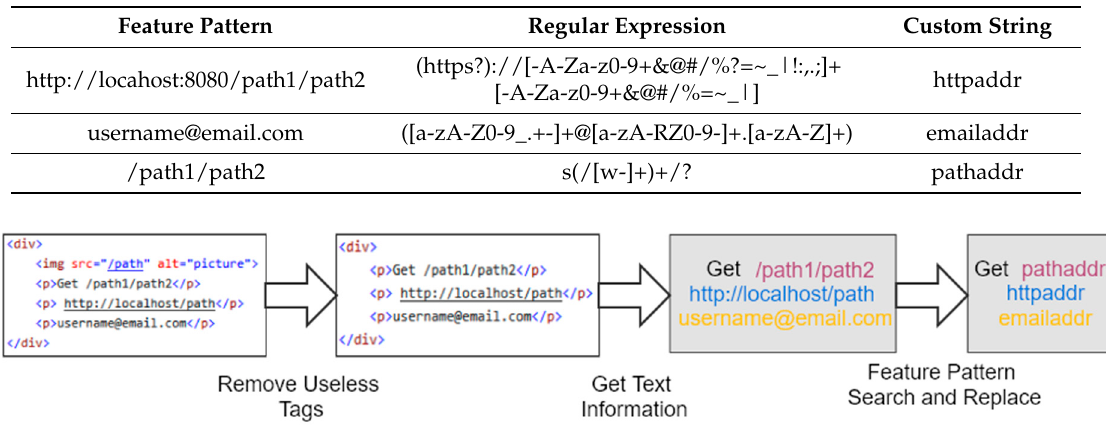
Figure 3. Example of HTML preprocessing.